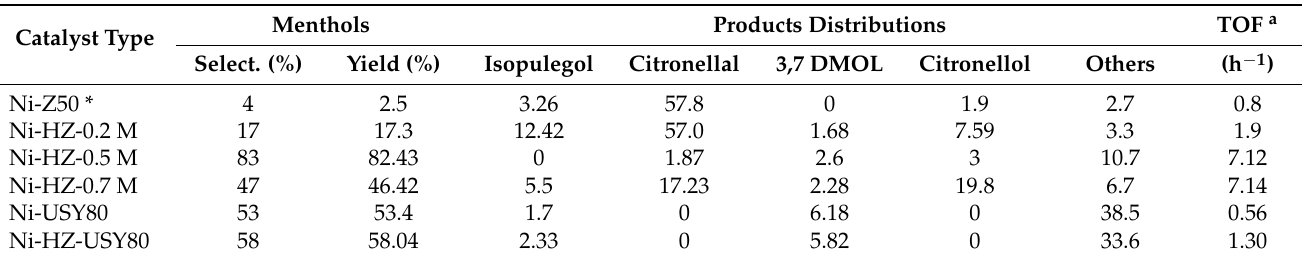
Table 4. Catalytic activities of Ni-supported hierarchical zeolites catalysts in citral hydrogenation to menthols.